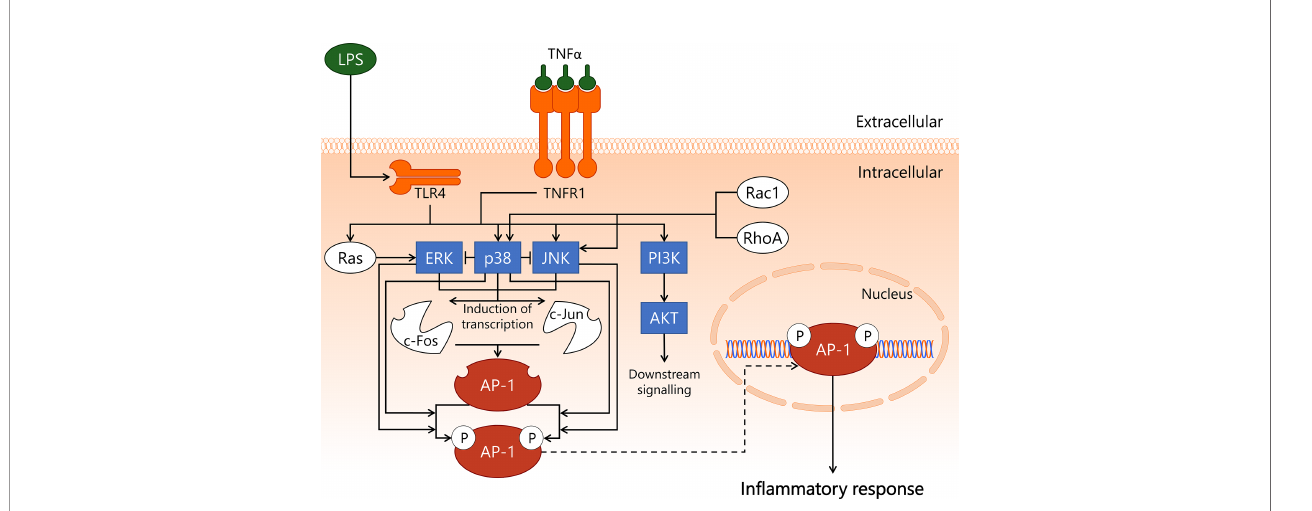
FIGURE 3 | Activation of transcription factor AP-1 in endothelial cells during sepsis. During onset and development of sepsis, transcription factor AP-1 becomes activated in the endothelium. LPS/TLR4 and TNF a /TNFR1 promote activity of PI3K/AKT, Ras/ERK, p38, and JNK kinases, whereas p38 and JNK can also become activated by Rac1 or RhoA. ERK, p38, and JNK induce the transcription of the c-Fos and c-Jun proteins, which can form the AP-1 heterodimer. Phosphorylation of AP-1 enhances its transcriptional function. The c-Fos component of AP-1 is phosphorylated by ERK and p38, whereas the c-Jun component of AP-1 is phosphorylated by p38 and JNK. AP-1 induces transcription of genes mainly associated with in fl ammation and apoptosis. AKT, protein kinase B; AP-1, activator protein 1; c-Fos, cellular Fos proto-oncogene; c-Jun, cellular Jun proto-oncogene; ERK, extracellular signal-regulated kinase; JNK, c-Jun N-terminal kinase; LPS, lipopolysaccharide; p38, p38 mitogen-activated protein kinase; PI3K, phosphoinositide 3-kinase; Rac1, Ras-related C3 botulinum toxin substrate 1; RhoA, Ras homolog gene family, member A; TLR4, Toll-like receptor 4; TNFR1, tumor necrosis factor alpha receptor 1; TNF a , tumor necrosis factor